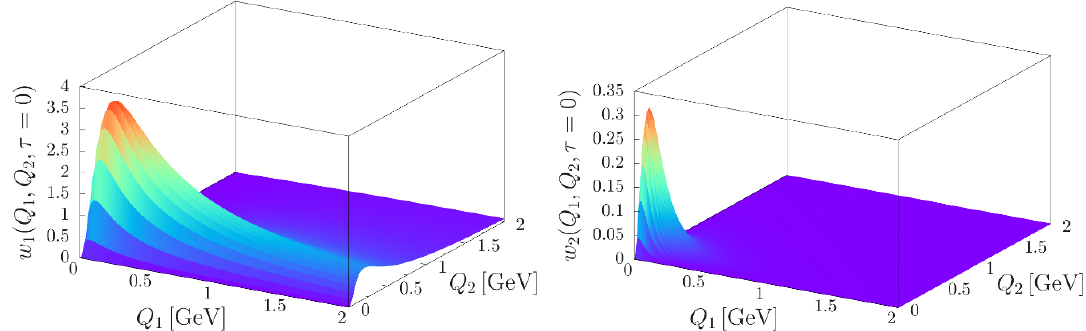
Figure 3. The weight functions w 1 ( Q 1 ; Q 2 ; (cid:28) ) (left diagram) and w 2 ( Q 1 ; Q 2 ; (cid:28) ) (right diagram) as functions of Q 1 and Q 2 for (cid:28) = 0 ; (cid:18) = 90 (cid:14)